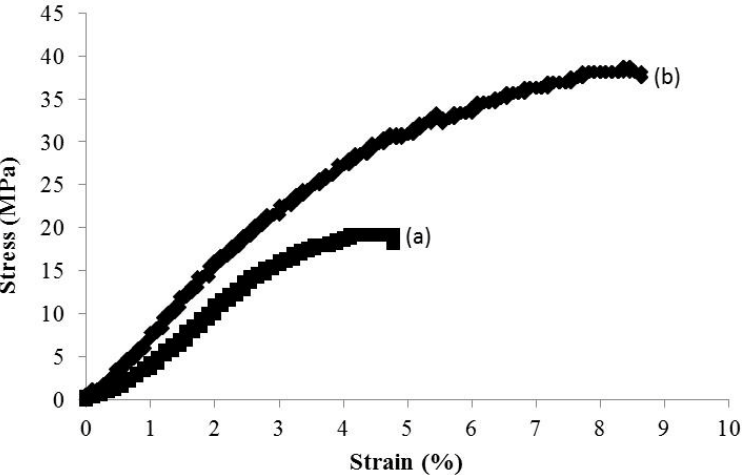
Figure 5. Stress–strain curves of films of 3 from (a) Avicel and (b) cotton after washing out